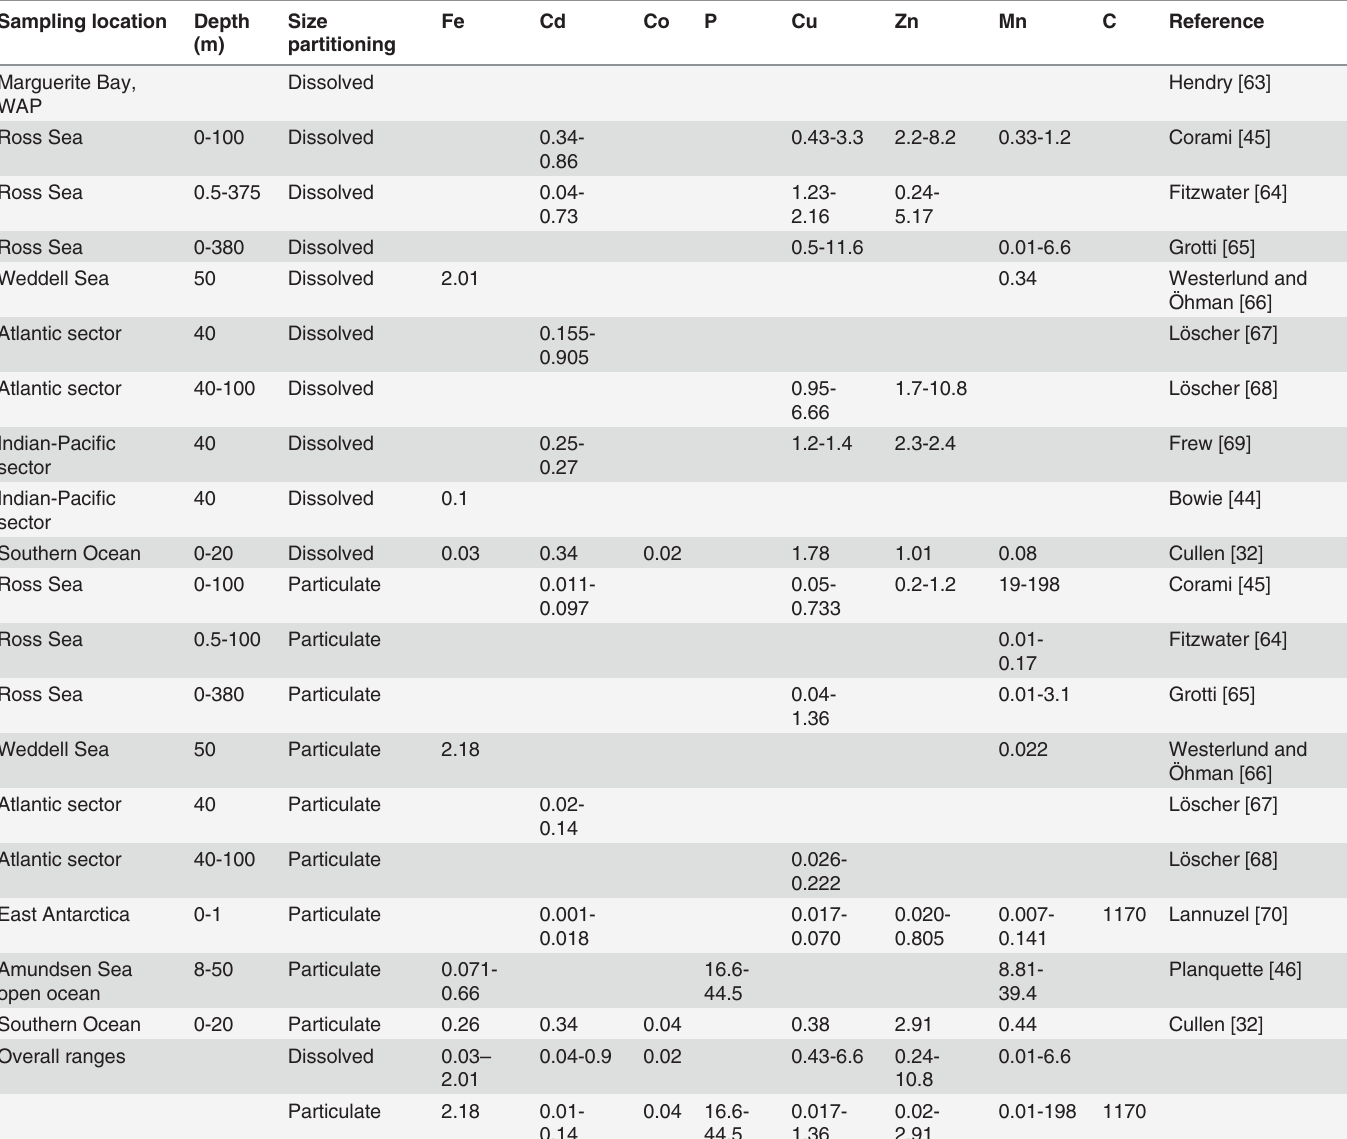
Table 3. Summary of dissolved and particulate trace element concentrations in surface waters from the literature (nmol L -1 ). Sampling